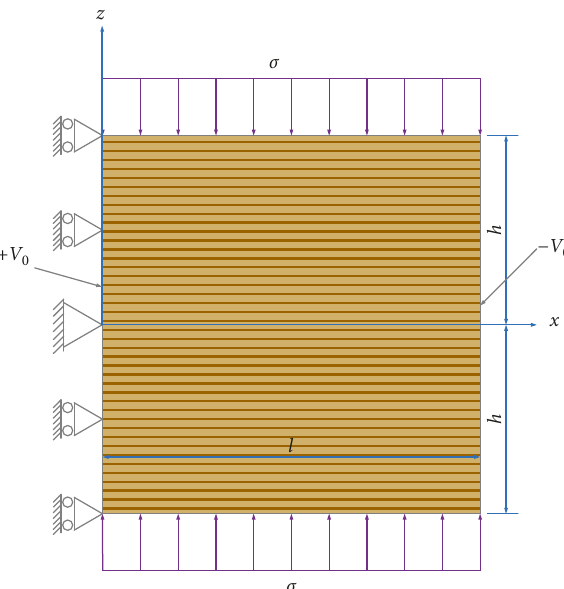
Figure 4: A singer-player PCMs strip under shear